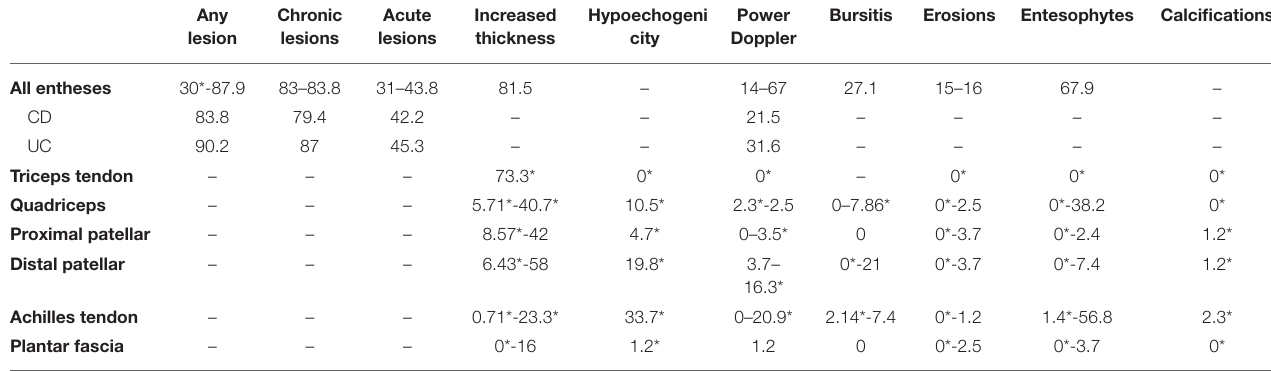
TABLE 2 | Summary of frequencies for each entheseal